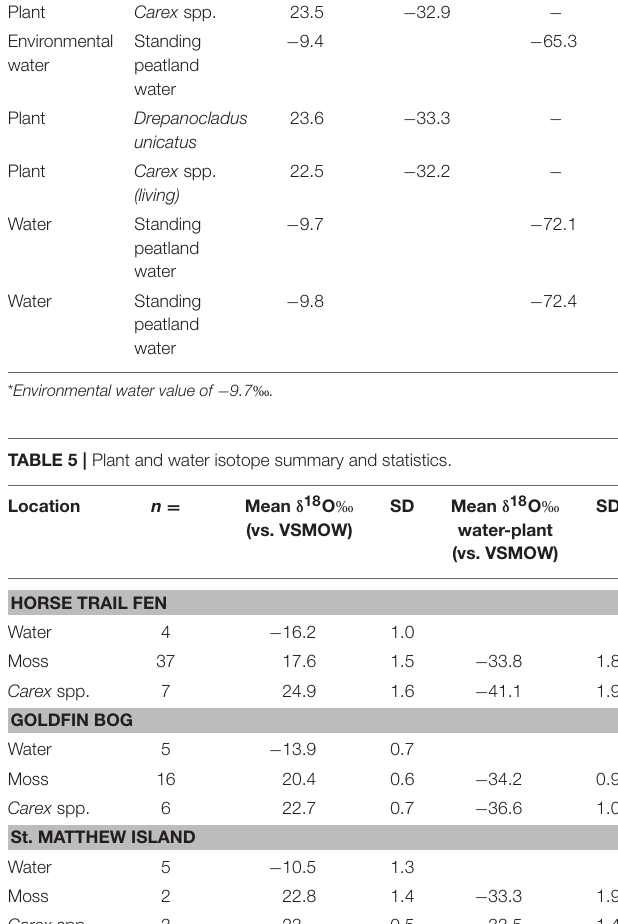
( Figure 2 ). Higher δ 18 O and δ 2 H values at GF ( ∼ 14.1, − 109.5‰, respectively), on the windward side of the Kenai Mountains compared to HTF ( − 16.2, − 124‰, respectively), on the leeward side, is consistent with Rayleigh distillation effects (Dansgaard, 1964) across the Kenai Mountain barrier. As moisture is lifted over the Kenai Mountains, heavier isotopes of precipitation are preferentially rained out on the windward side, whereas on the leeward side precipitation values are relatively-isotopically enriched in light isotopes. Consequently, GF waters are 2‰ higher than HTF, and this relationship held for the average range of δ 18 O cellulose values for the two peatland sites despite